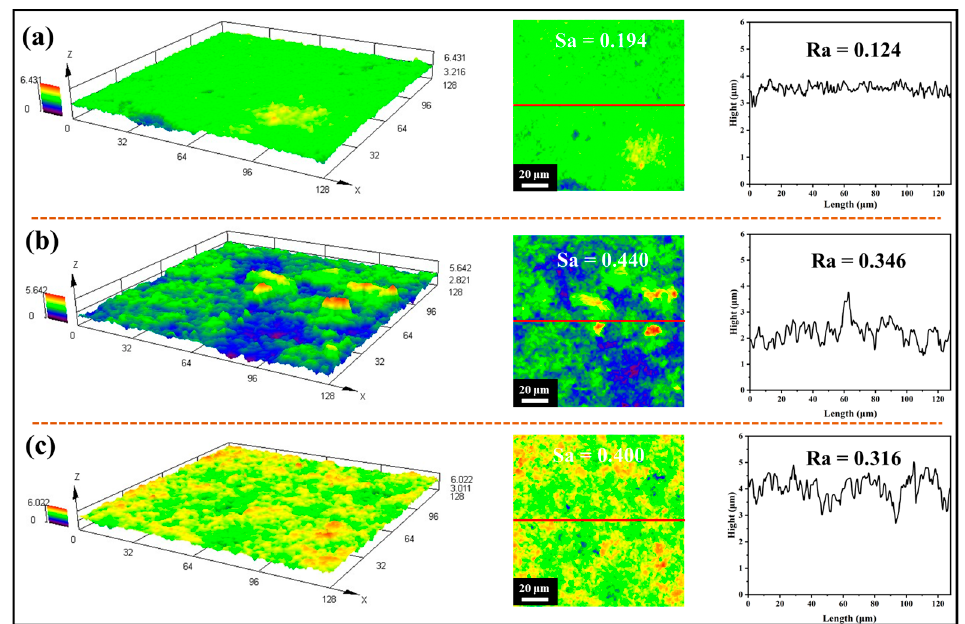
Figure 6. ( a ) 3D surface morphology, 2D morphology, and line roughness of S1 sample; ( b ) 3D surface morphology, 2D morphology, and line roughness of S2 sample; ( c ) 3D surface morphology, 2D morphology, and line roughness of S3 sample.